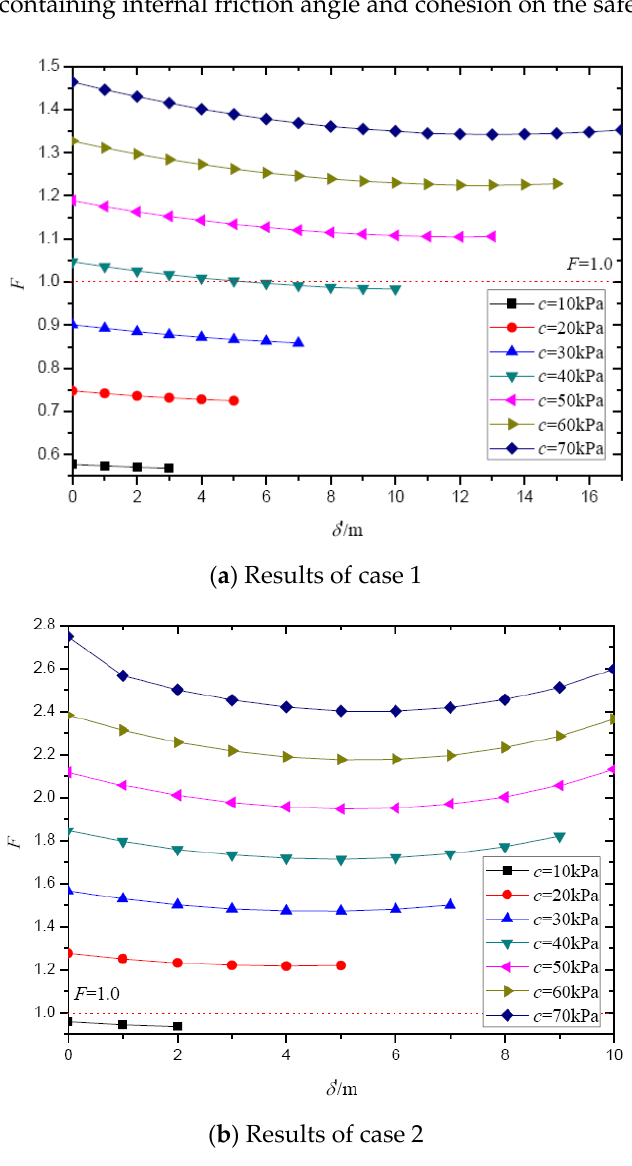
Figure 12. Relationship between safety factor and crack depth under different cohesion of soil.